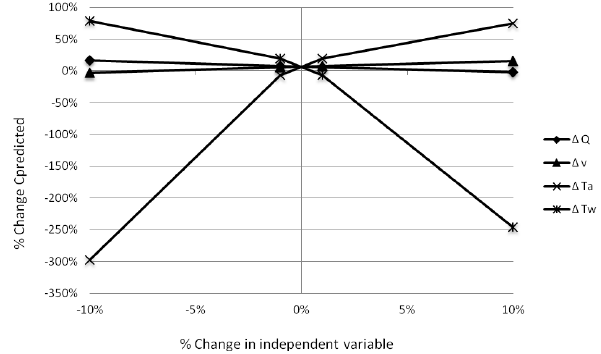
Fig. 6. Model sensitivity of nitrogen concentration to changes in Figure 6. Model sensitivity of nitrogen concentration to changes in input parameters ( Q – 3 input parameters ( Q – flow, υ – velocity of water in the stream, T a flow, υ – velocity of water in the stream, T a – temperature of air, T w – temperature of water). 4 – temperature of air, T w – temperature of water).